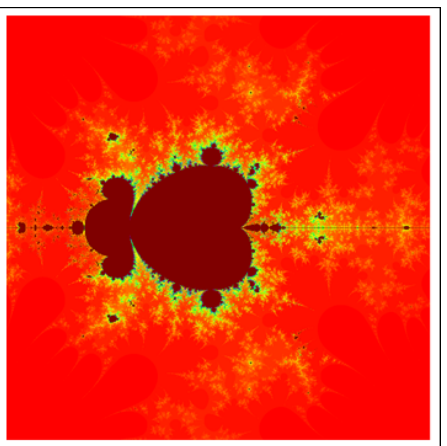
Figure 41. M-set via F-iteration for sin ( z 2 ) + c with time of generation = 239.5.